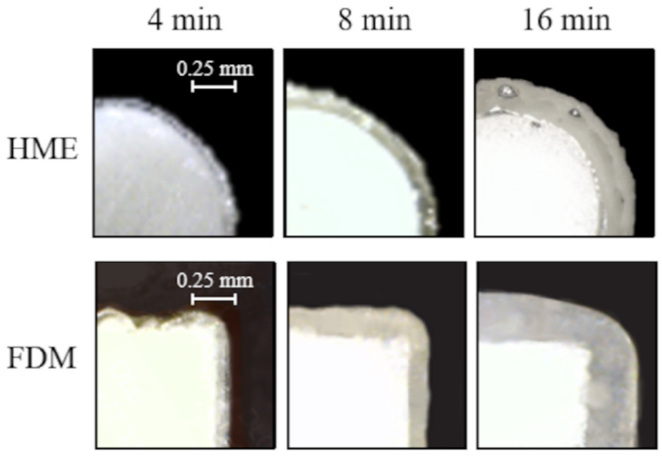
Figure 4. Photographs of the cross-section of extruded and printed samples coated with the Eudragit ®